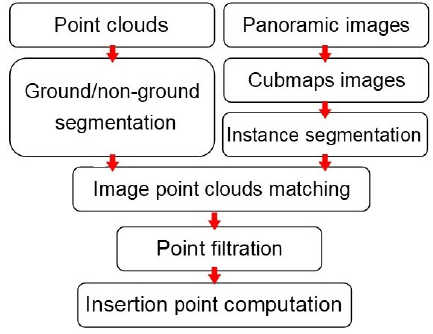
Figure 1. Streetlamp’s detection and vectorization workflow.